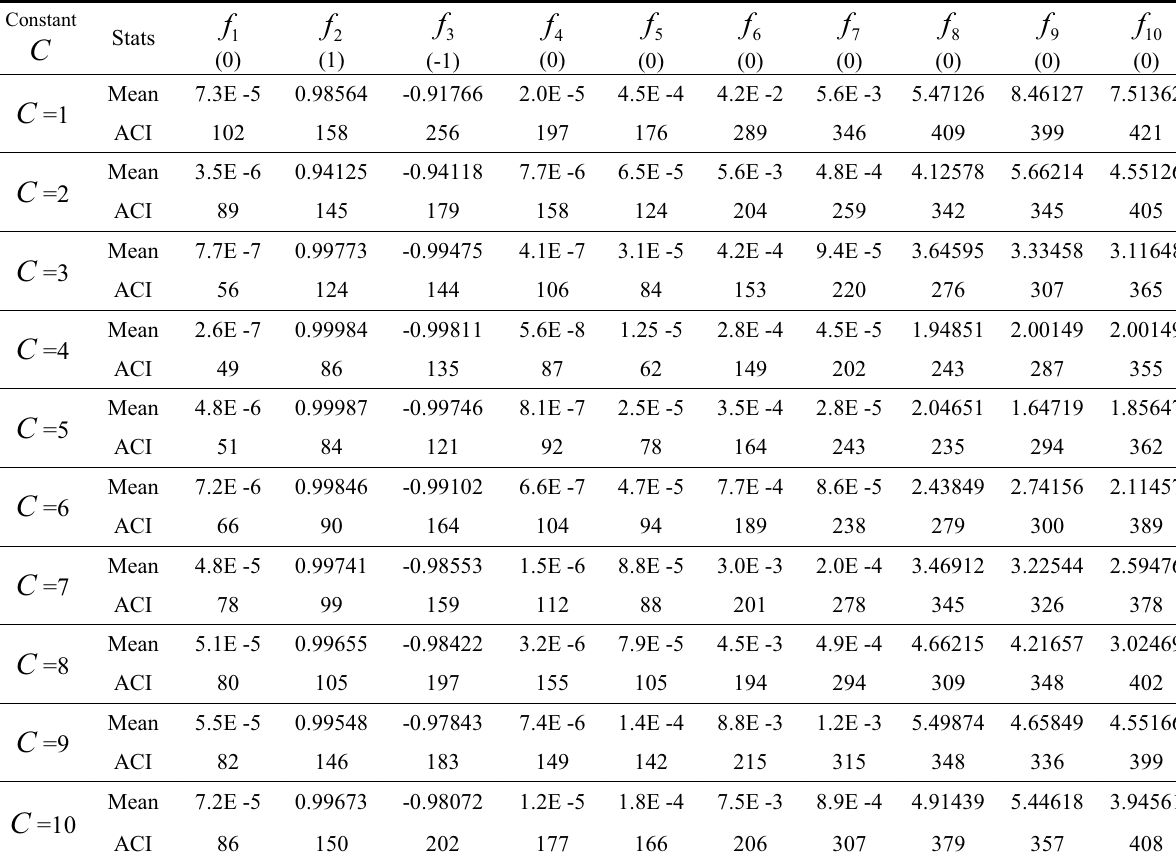
Table 4. Simulation results of different constant C with